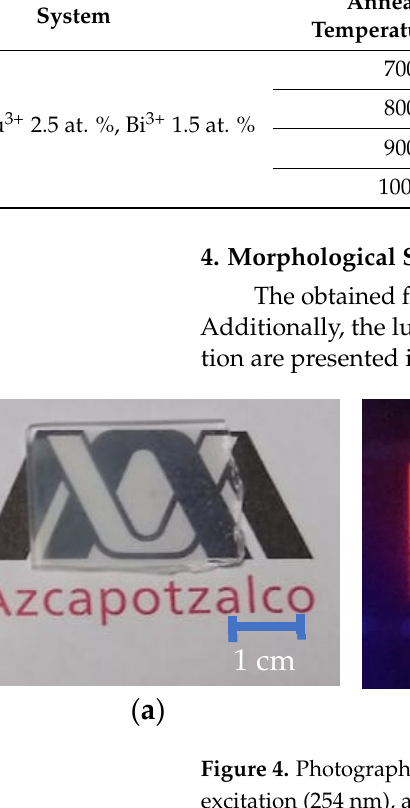
Table 1. Crystallite size and preferential orientation index of LuVO 4 : 2.5% at. Eu 3+ , 1.5% at. Bi 3+ films as a function of annealing temperature. Annealing System Crystallite Size (nm) Temperature ( ◦ C)